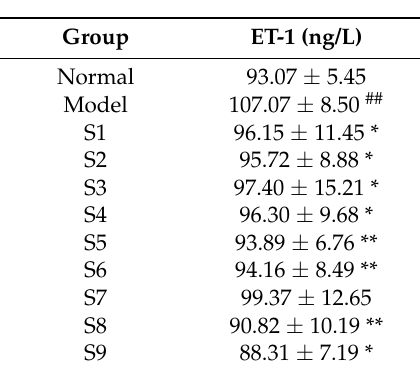
Table 3. The content of ET-1 in plasma.